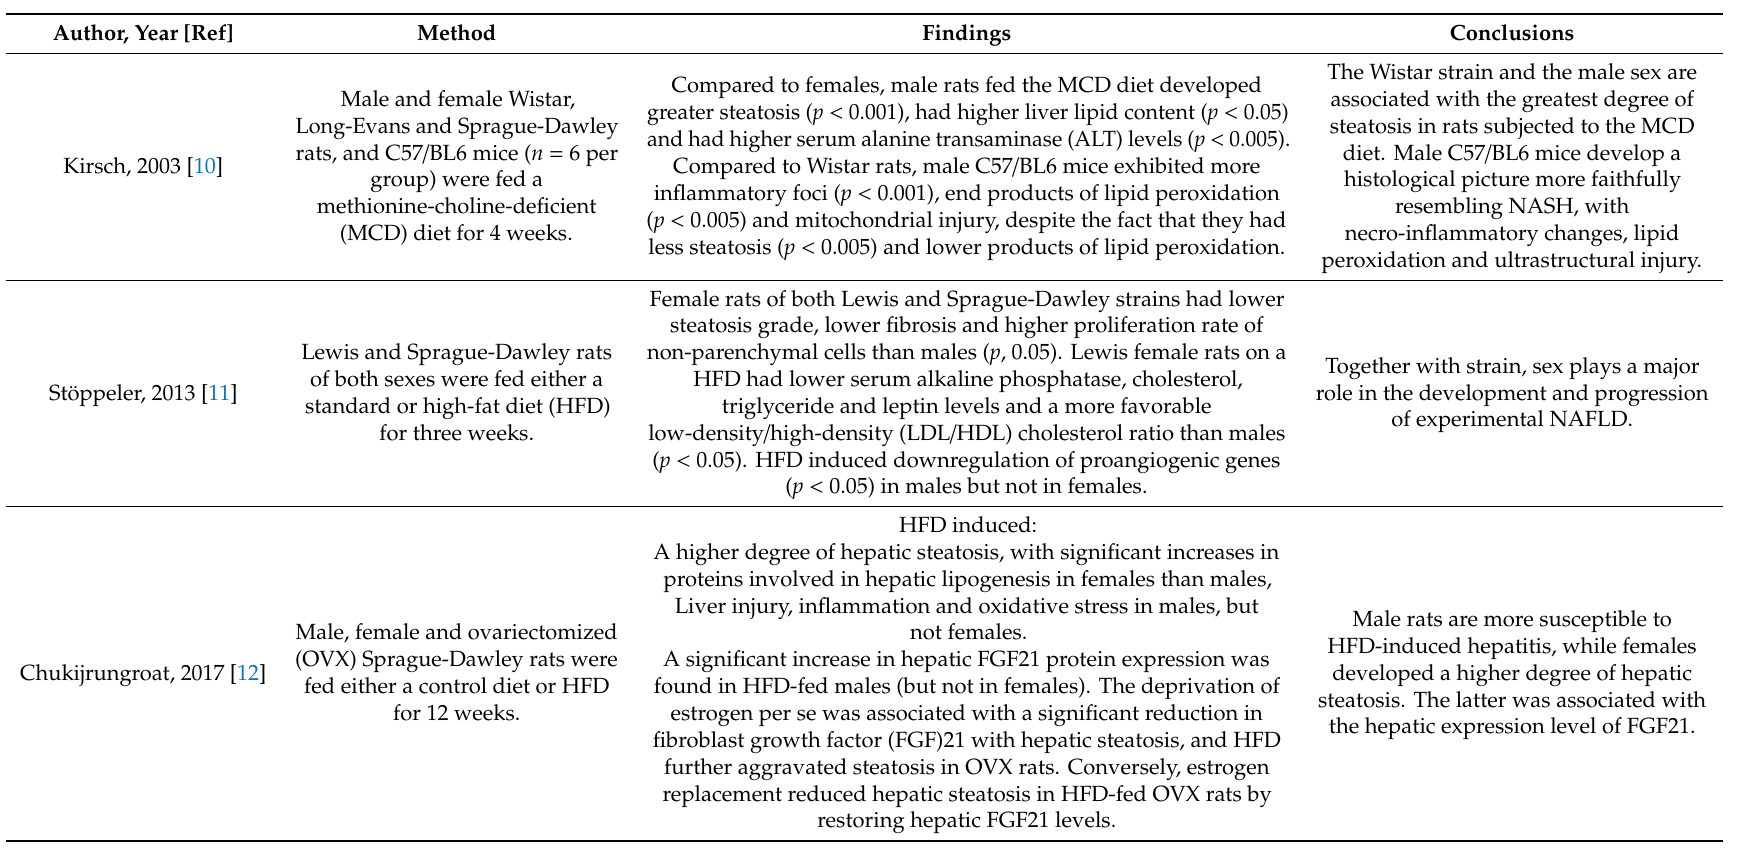
Table 1. Sexual dimorphism of nonalcoholic fatty liver disease (NAFLD). Evidence from experimental